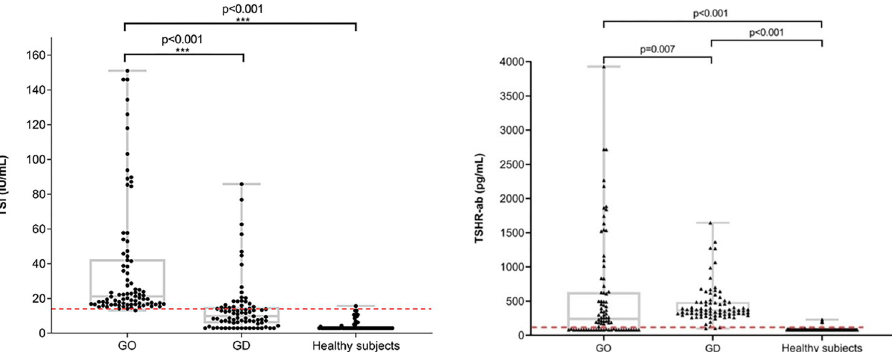
Fig 2. a, b. TSI and TSHR-ab levels in each group. Abbreviation: GO, Graves’ ophthalmopathy; GD, Graves’